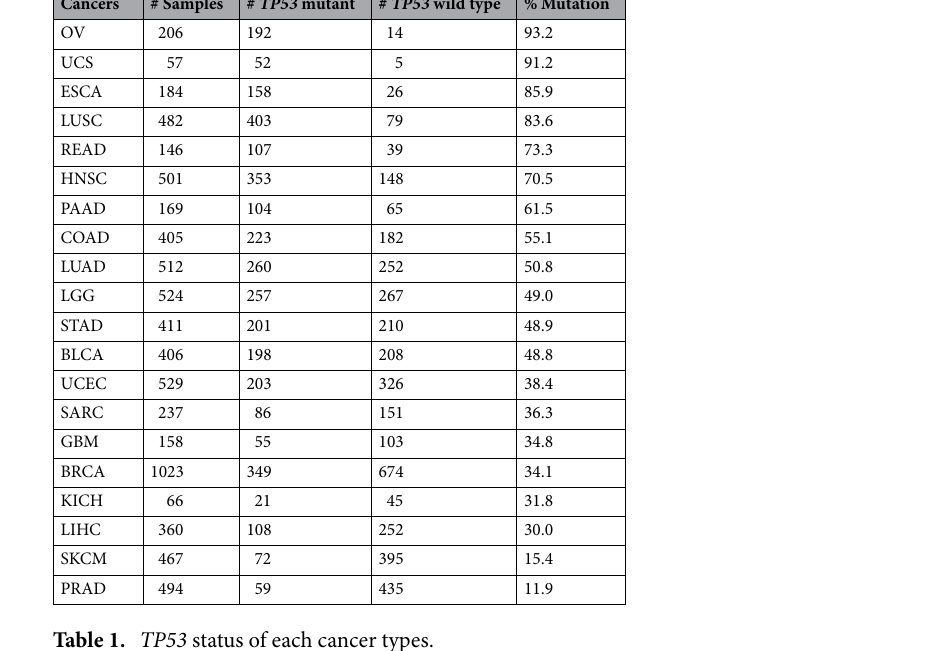
Table 1. TP53 status of each cancer